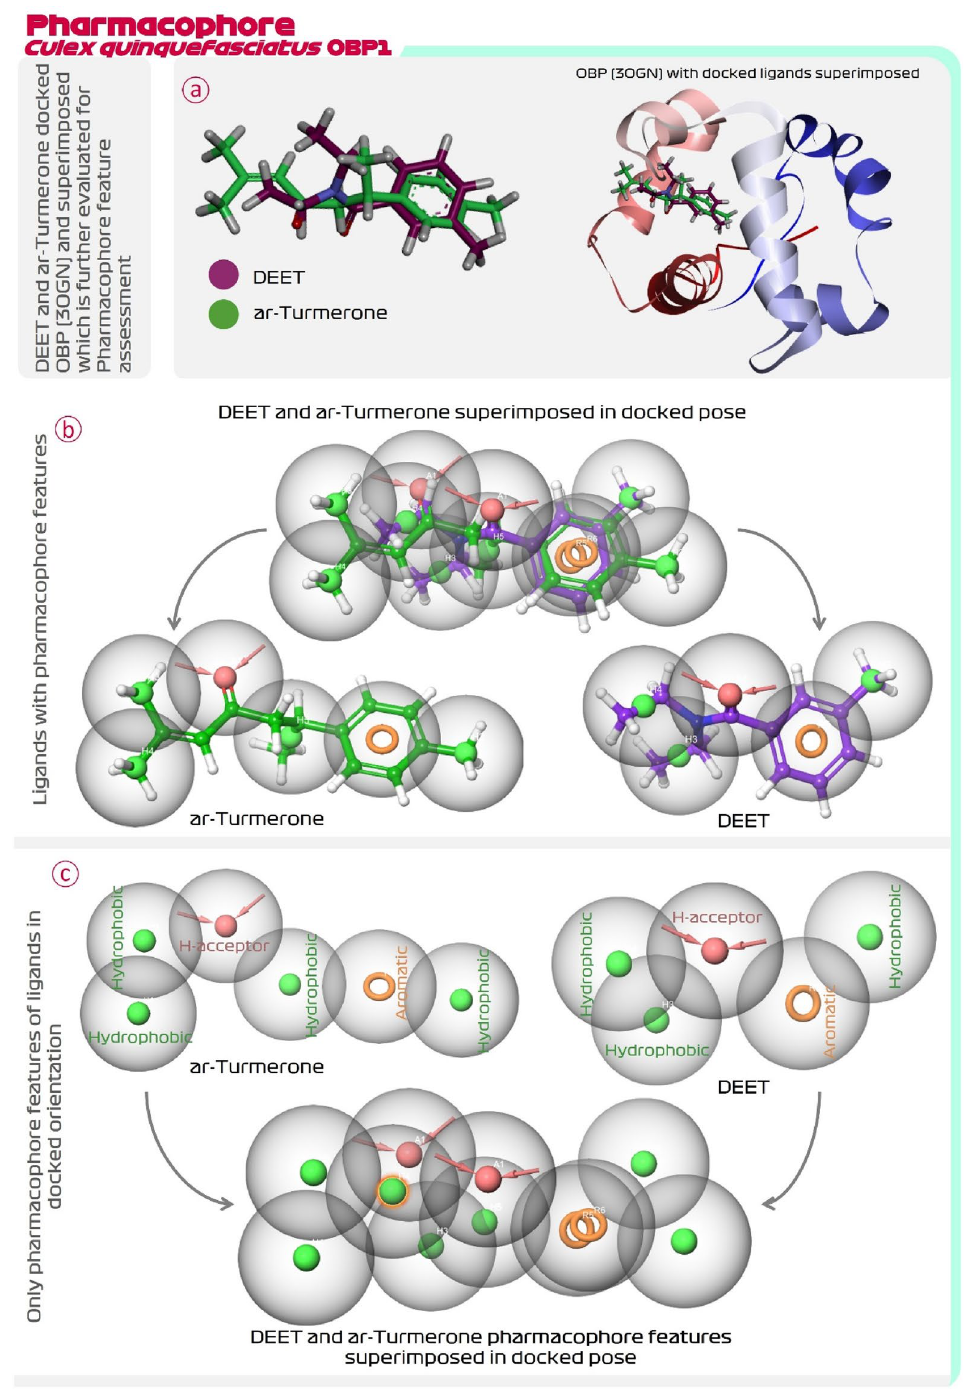
Figure 2. ( a ) Superimposition of docked DEET and ar-turmerone with OBP1 (3OGN) of C. quinquefasciatus, ( b ) Pharmacophore feature mapping of DEET and ar-turmerone with ligands displayed and ( c ) Pharmacophore feature mapping of DEET and ar-turmerone without ligands